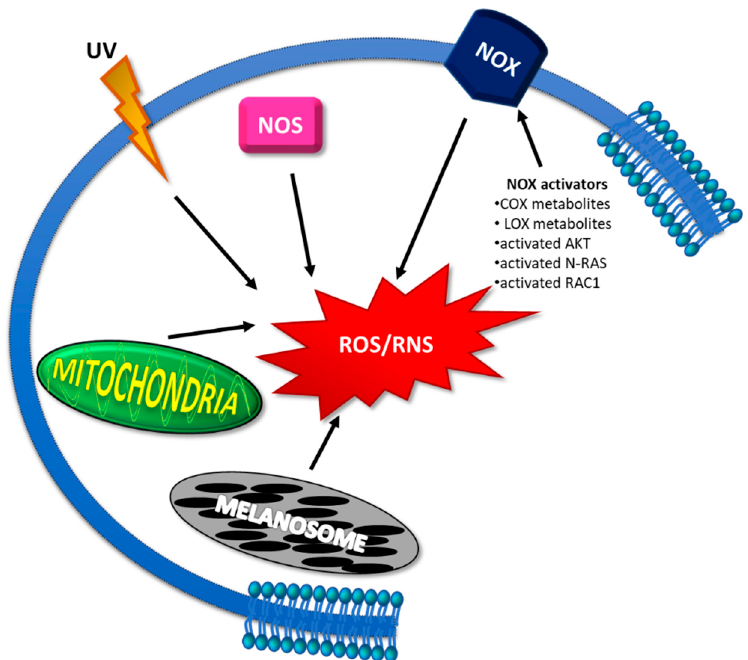
Figure 1. Major ROS sources in melanocytes. ROS can be generated from UV irradiation, melanosomes, mitochondria, and NOS and NOX family enzymes. Moreover, NOX enzymes can be activated by arachidonic acid metabolites from both the COX and LOX pathways, as well as from the activated N-RAS, AKT, and RAC1 oncogenic pathways.